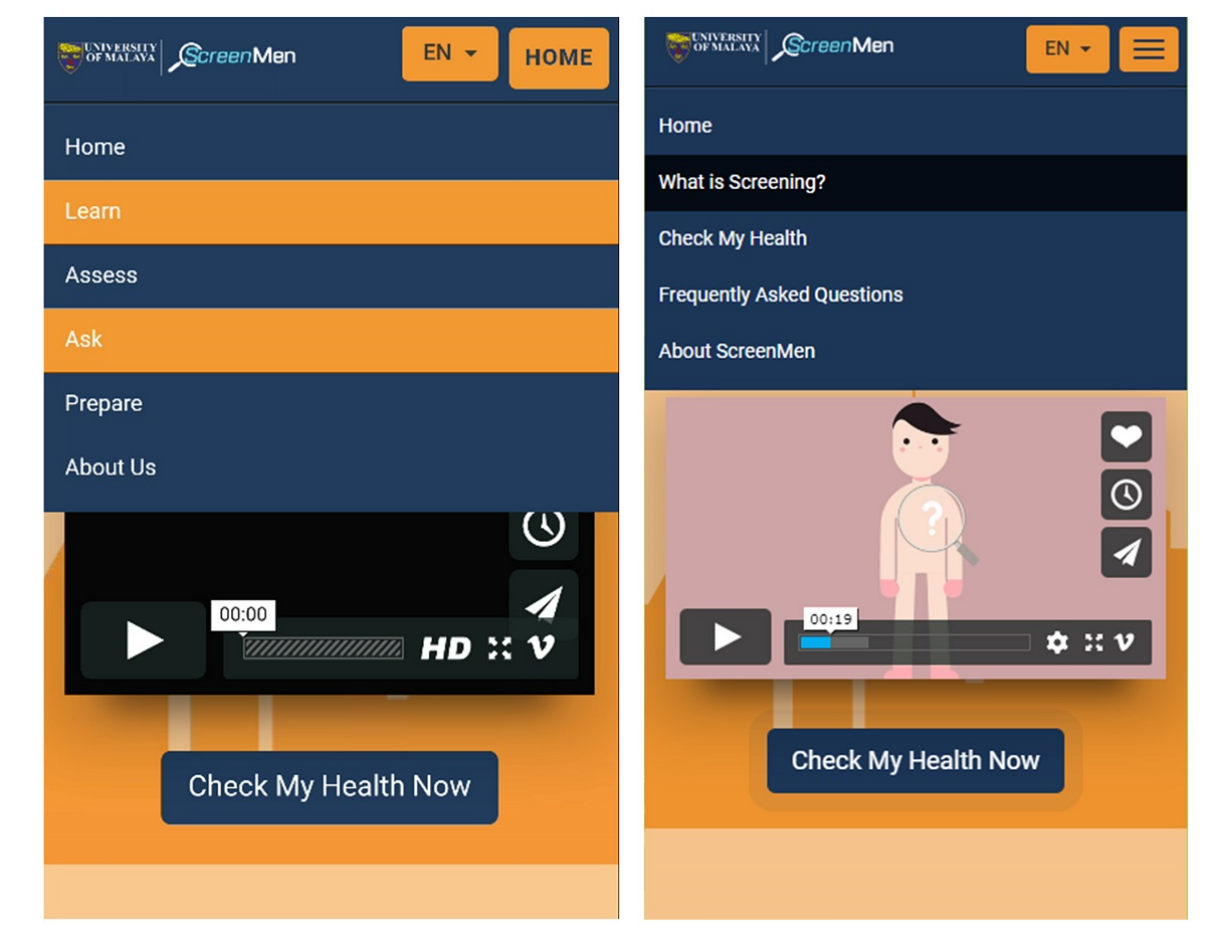
Figure 2. The menus of ScreenMen before and after